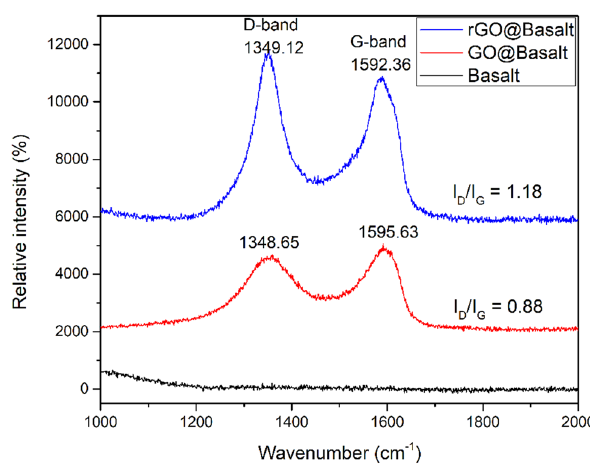
Figure 4: Raman analysis of basalt fi ber ( Basalt ) , GO - coated basalt fi ber ( GO@Basalt ) , and rGO - coated basalt fi ber ( rGO@Basalt )